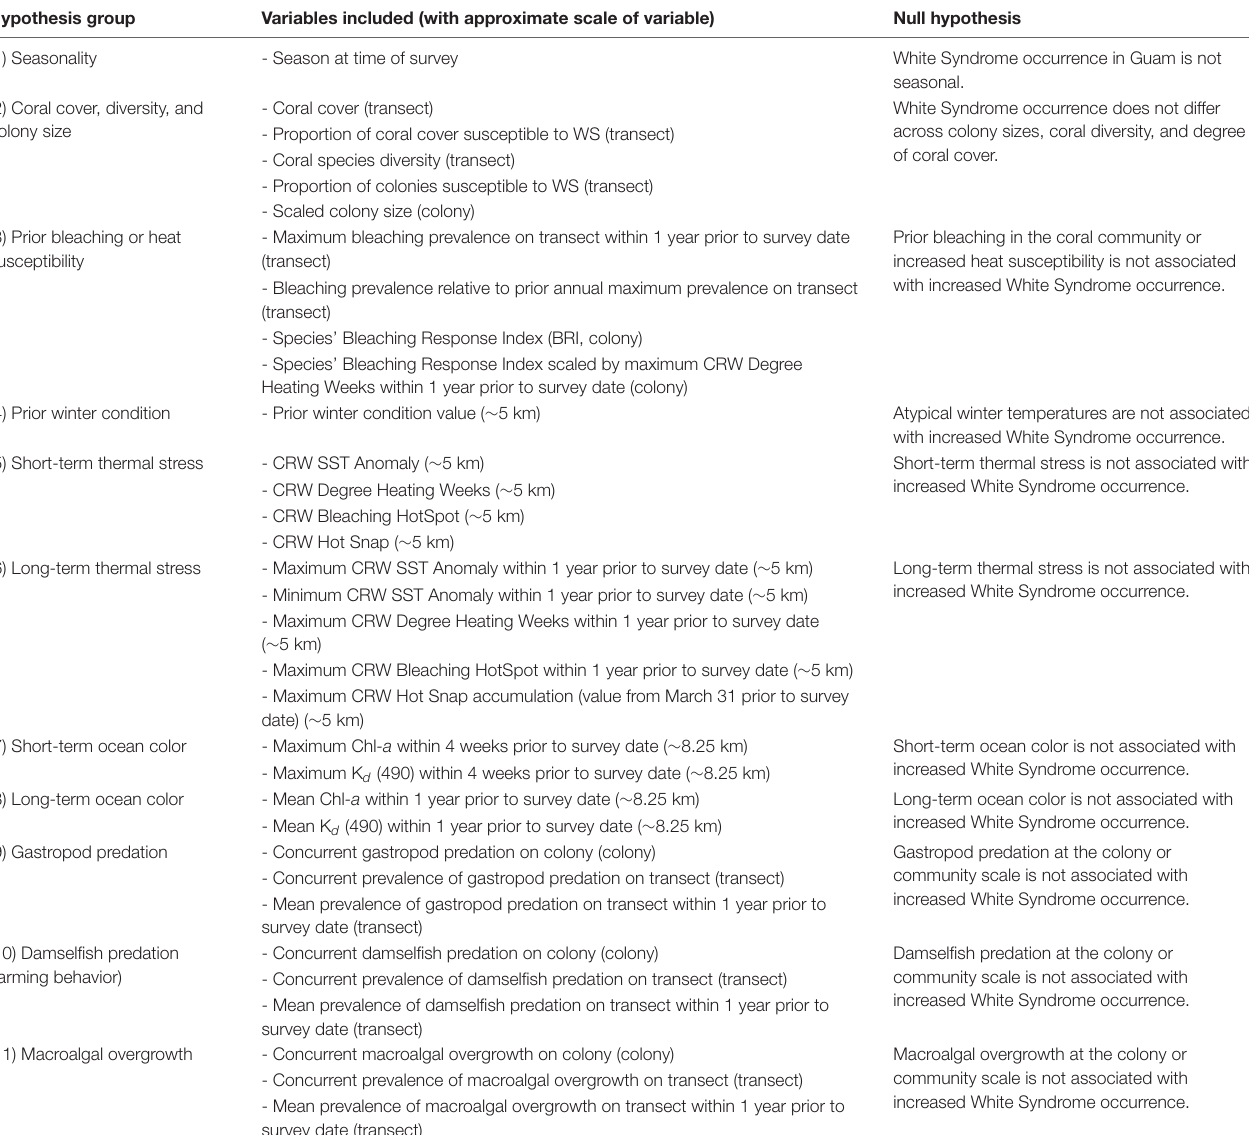
TABLE 2 | Hypothesized environmental and biological drivers of White Syndrome. Hypothesis group Variables included (with approximate scale of variable) Null hypothesis